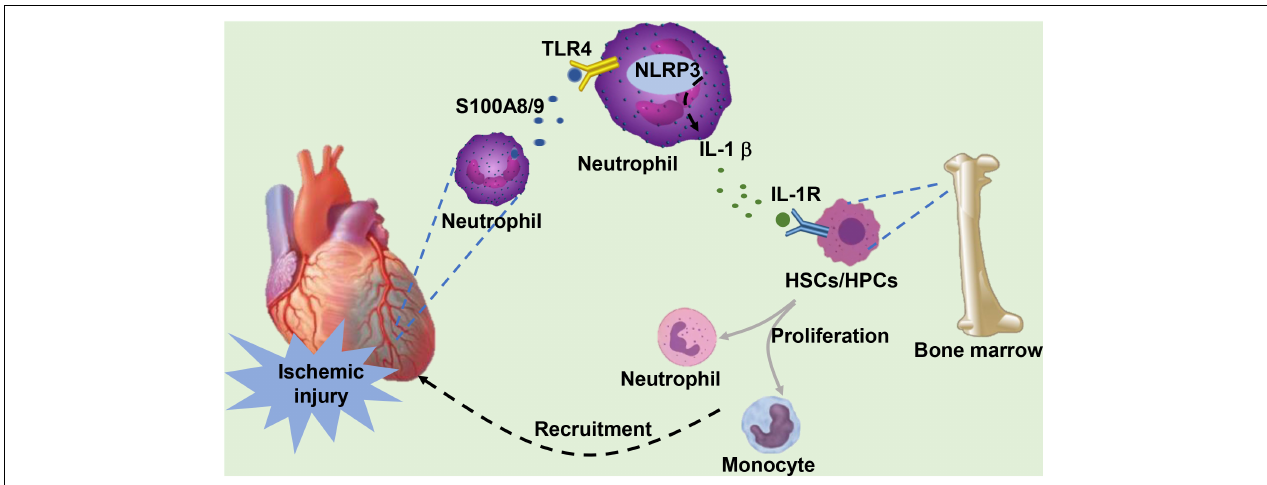
FIGURE 1 | Under ischemic injury, neutrophils infiltrating the heart secrete S100A8/A9. S100A8/A9 binds to TLR-4 on the surface of cardiac or circulating neutrophils, subsequently activating the formation of downstream NLRP3 and stimulating the release of IL-1 β . IL-1 binds to IL-1R on the surface of hematopoietic stem cells (HSCs) and hematopoietic progenitor cells (HPCs) in the bone marrow, which stimulates the proliferation and differentiation of HSCs into neutrophils and monocytes. These cells are eventually recruited to the infarcted heart in response to ischemic